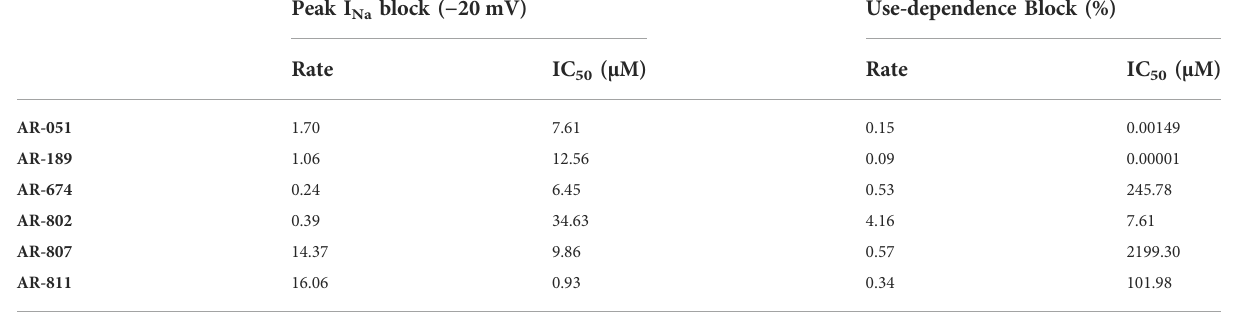
TABLE 4 Hill function parameters for peak I NA and use-dependence block.